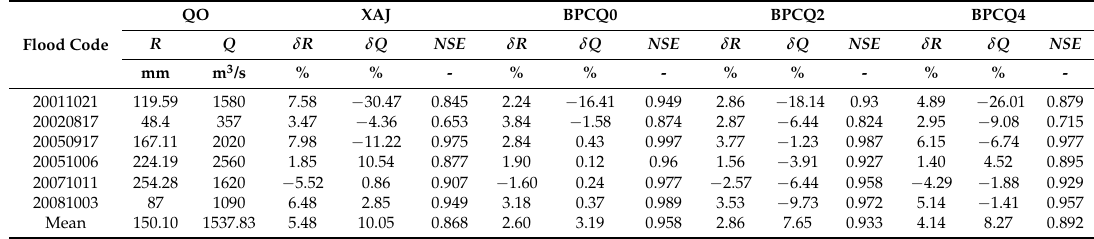
Table 3. Single period correction performance for validation period.